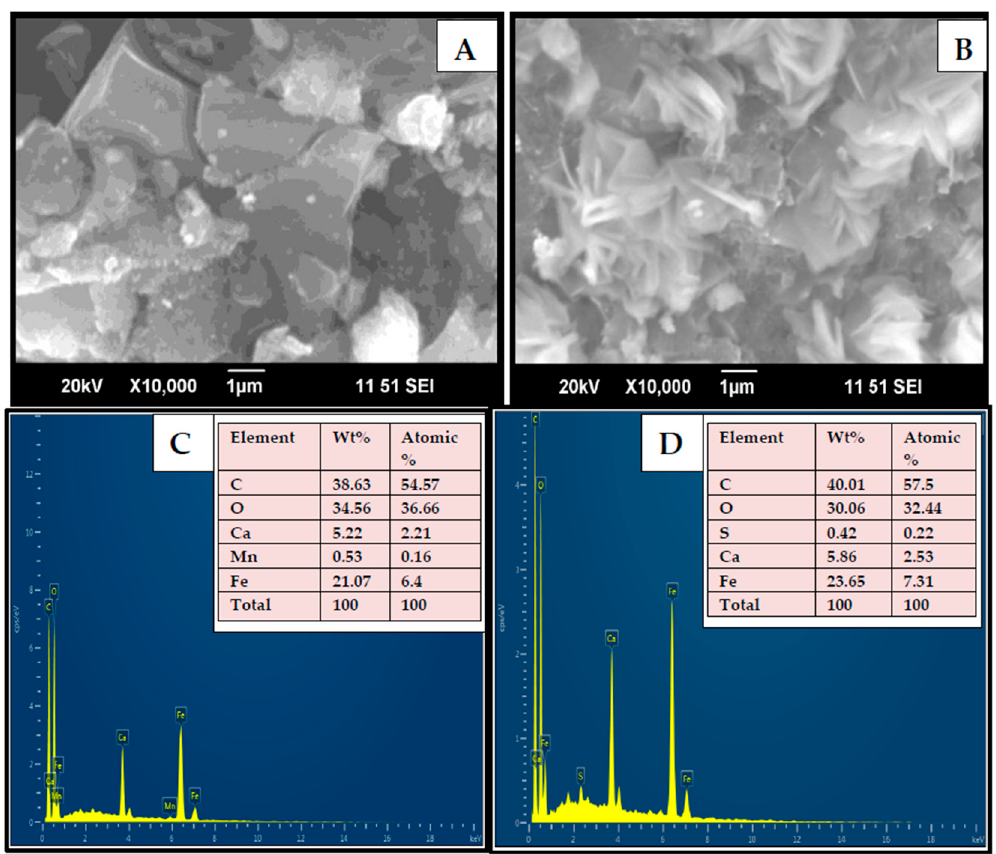
Figure 2. SEM-Energy Dispersive X-ray Spectrometry (EDX) images of Fe 3 O 4 / AC / CD / Alg polymer beads before ( A ) and after ( B ) adsorption. Elemental analysis of Fe 3 O 4 / AC / CD / Alg polymer beads before ( C ) and after ( D ) adsorption.